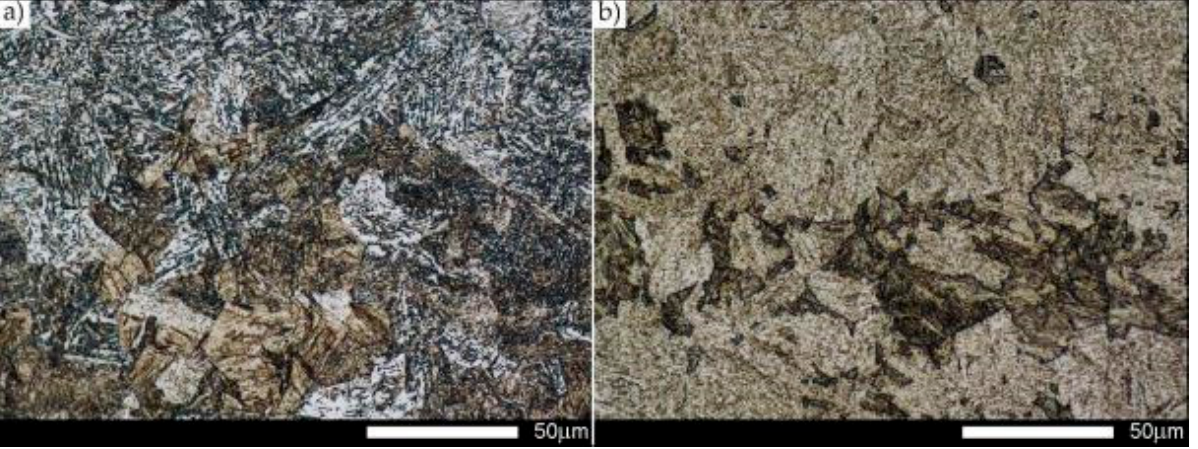
Figure 5. Magnified images of the central zones of the microphotography shown in Figure 4. ( a ) Longitudinal orientation. ( b ) Transverse orientation. The microstructures consisting of quenching sorbite and quenching martensite. Light microscopy, etched with 3% HNO 3 .